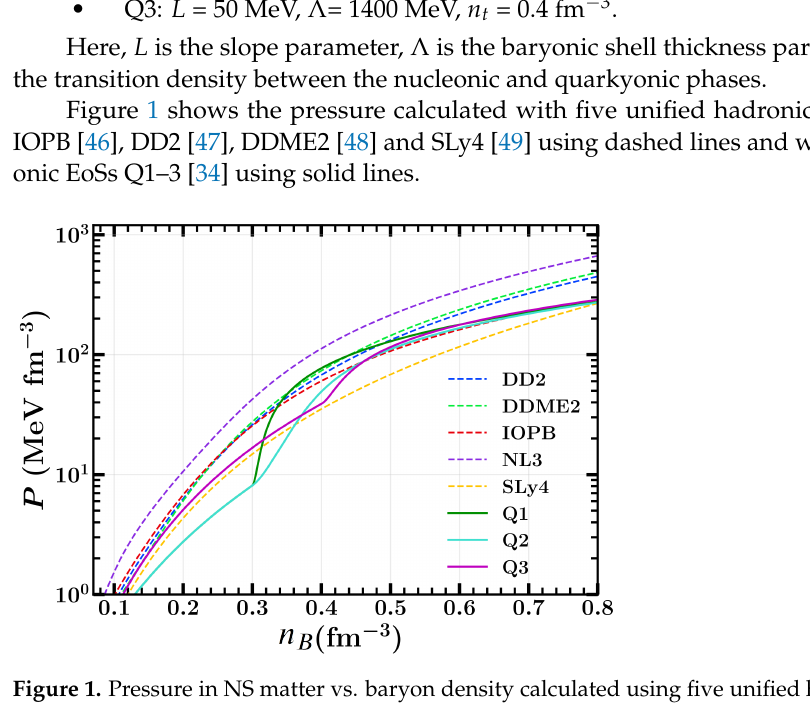
Figure 1. Pressure in NS matter vs. baryon density calculated using five unified hadronic as well as three quarkyonic EoSs